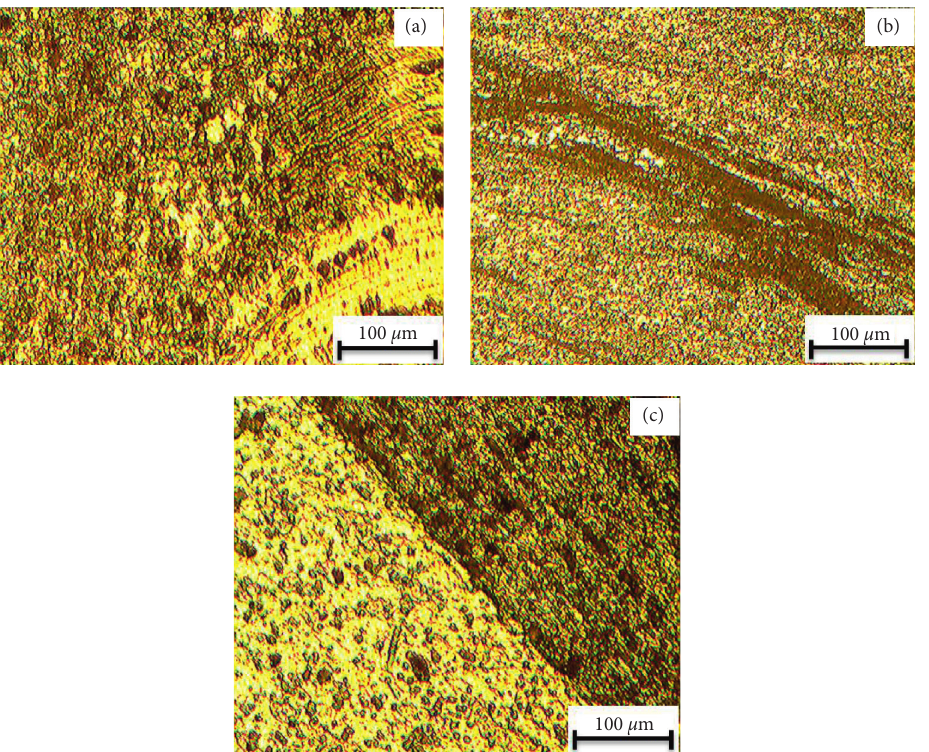
Figure 9: Optical micrographs of (a) RS-interface, (b) nugget top, and (c) AS-interface